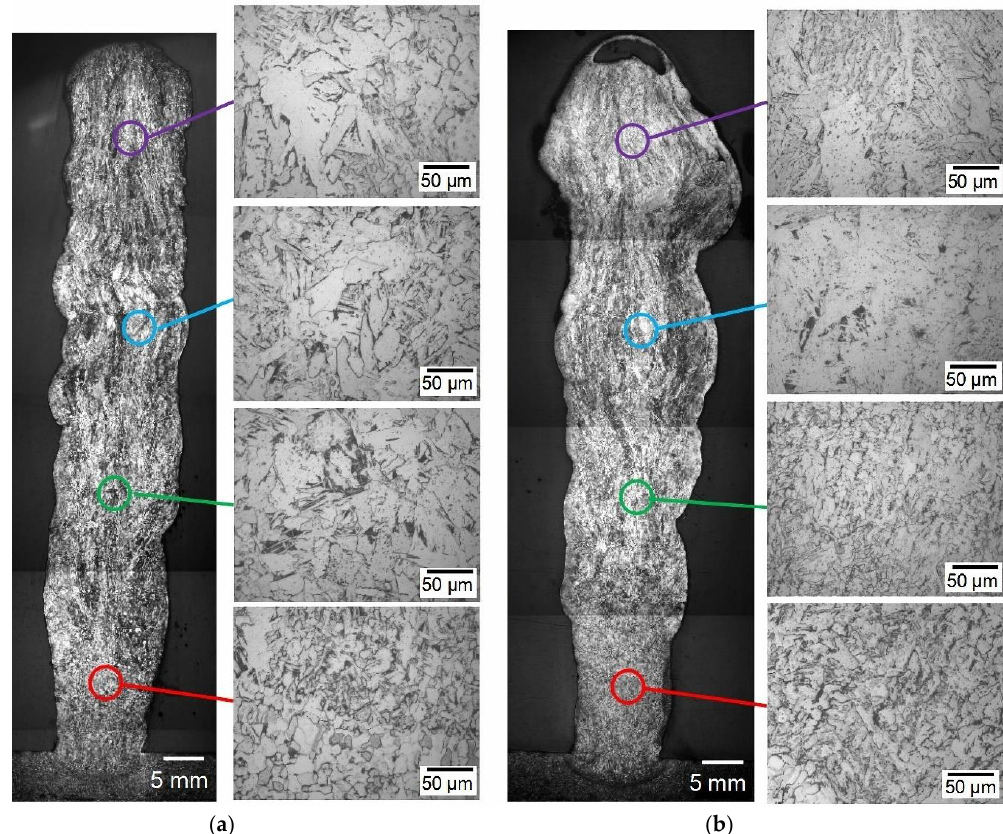
Figure 10. The optical microstructure of the multilayer weld deposition: ( a ) 316L standard wire; ( b ) 316L wire with Ni-LaB 6 coating of 6 μm in thickness.